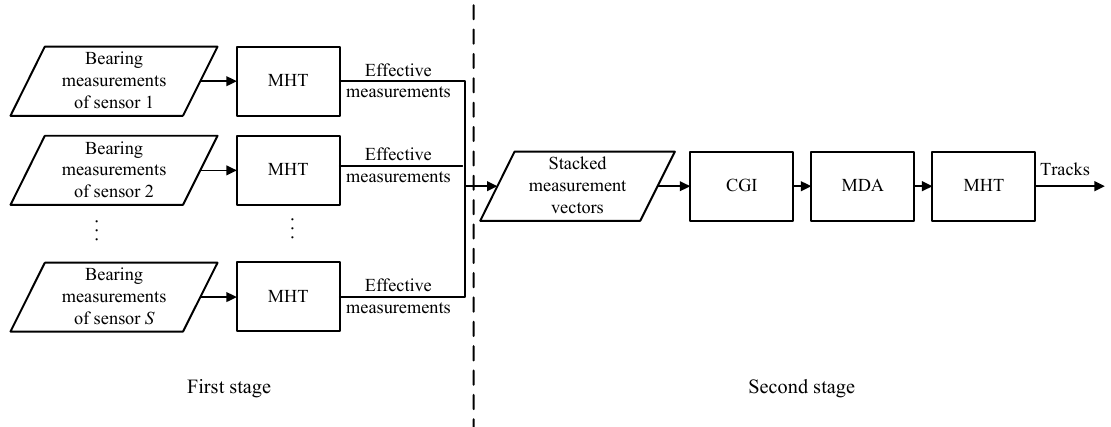
Figure 6. Framework of